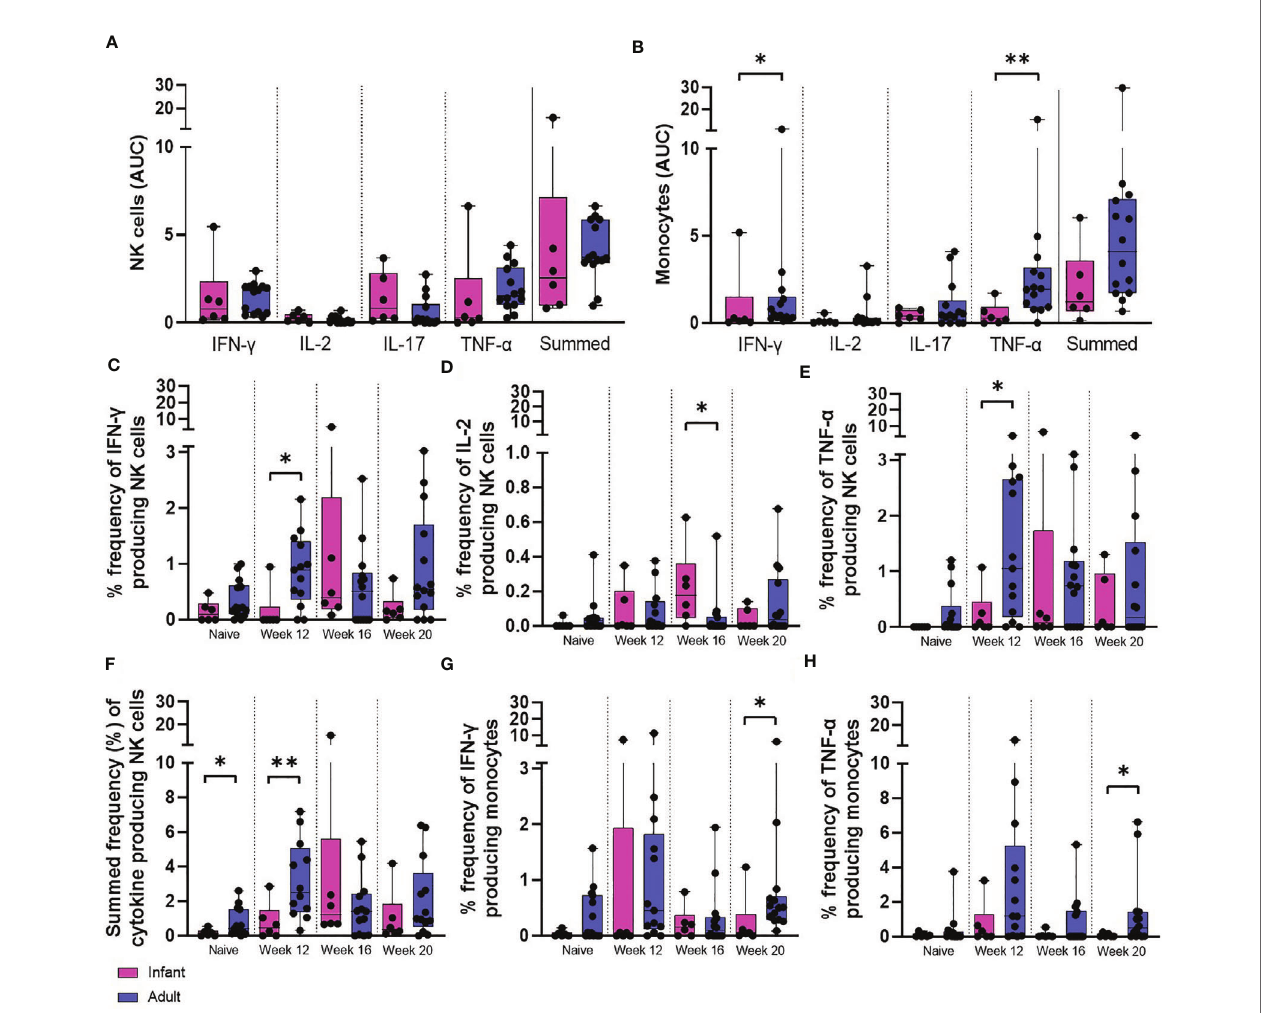
FIGURE 8 | PPD-induced cytokine production by NK cells and monocytes. Total PPD-induced cytokine production by (A) NK cells and (B) monocytes. Dots represent the AUC of cells producing IFN- g , IL-2, IL-17, TNF- a and summed frequencies of cytokine producing cells measured in stimulated whole blood collected from individual infant (pink bars) and adult (blue bars) animals between weeks 12 and 20. Plots show the frequency of (C) IFN- g , (D) IL-2, (E) TNF- a and (F) Total summed cytokine produced by NK cells and (G) IFN- g and (H) TNF- a produced by monocytes prior to and following ID BCG vaccination. Box plots show the group median +/- the inter-quartile range, with minimum and maximum values connected by whiskers. Signi fi cant differences measured by Mann-Whitney U-test between the groups are indicated. *p ≤ 0.05, **p <